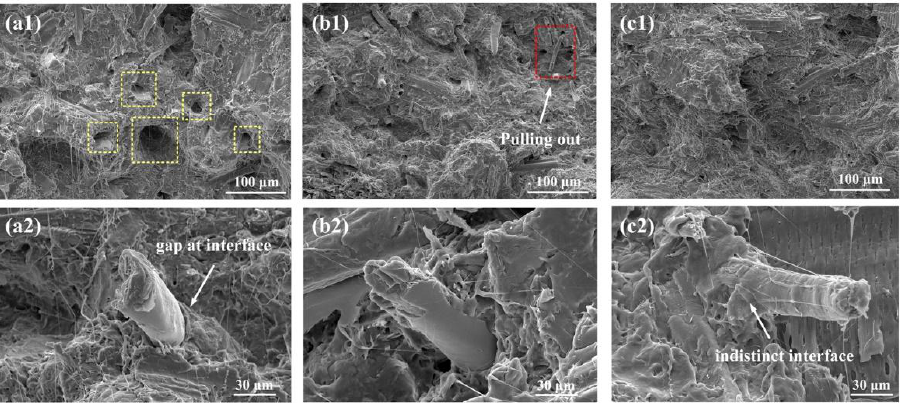
Figure 7. SEM fracture micrographs of: ( a1 , a2 ) C–BFs/PBS; ( b1 , b2 ) PDA–BFs/PBS; and ( c1 , c2 ) PDA/ODA–BFs/PBS composites at different magnifications.